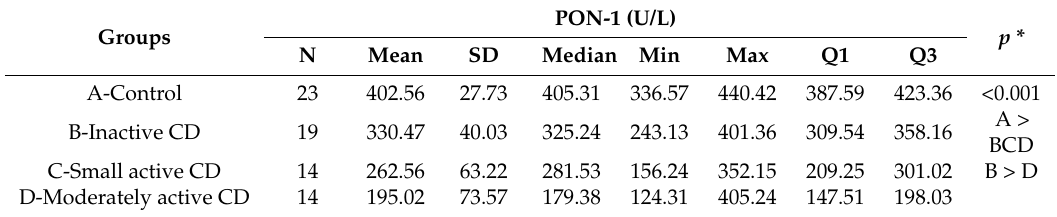
Table 2. Activity of paraoxonase-1 (PON-1) in the plasma of patients with Crohn’s disease (CD) and in control volunteers.